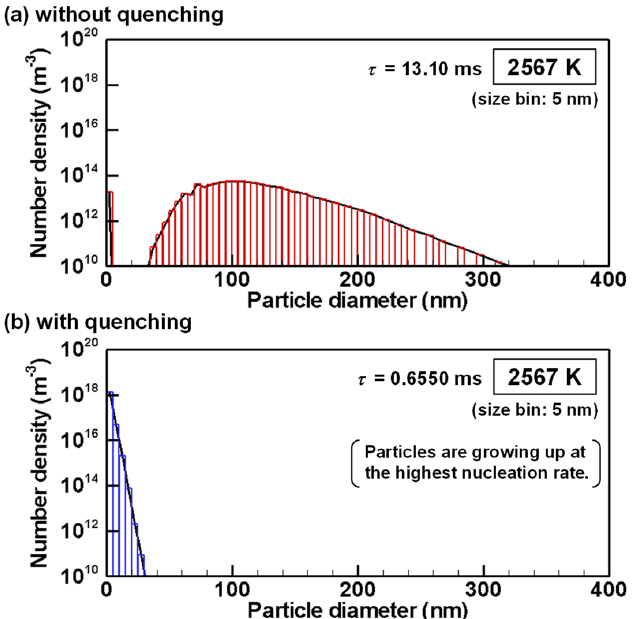
Figure 14. Size distributions of silicon nanoparticles at 2567 K ( a ) without and ( b ) with quenching. Figure 15a,b show unimodal size distributions without and with quenching at τ = 163.75 ms and τ = 8.1873 ms, respectively. At these moments, the temperatures are 2100 K identically and 99% of the vapor atoms have already been converted into nanoparticles as shown in Figure 7. Therefore, after these moments, the nanoparticles grow by interparticle coagulation.